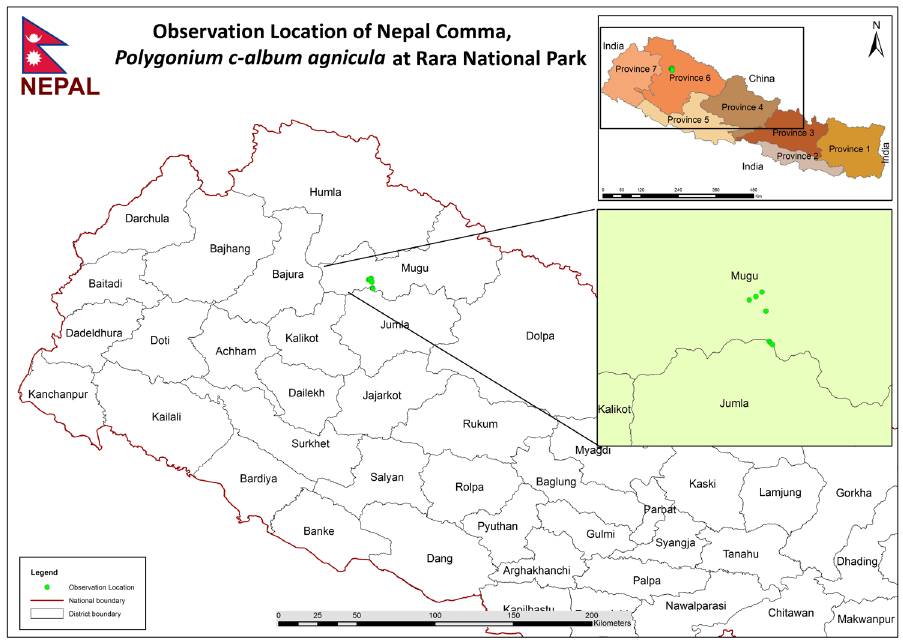
Figure 2. Observation locations of Nepal comma, Polygonia c-album agnicula in Rara National Park,